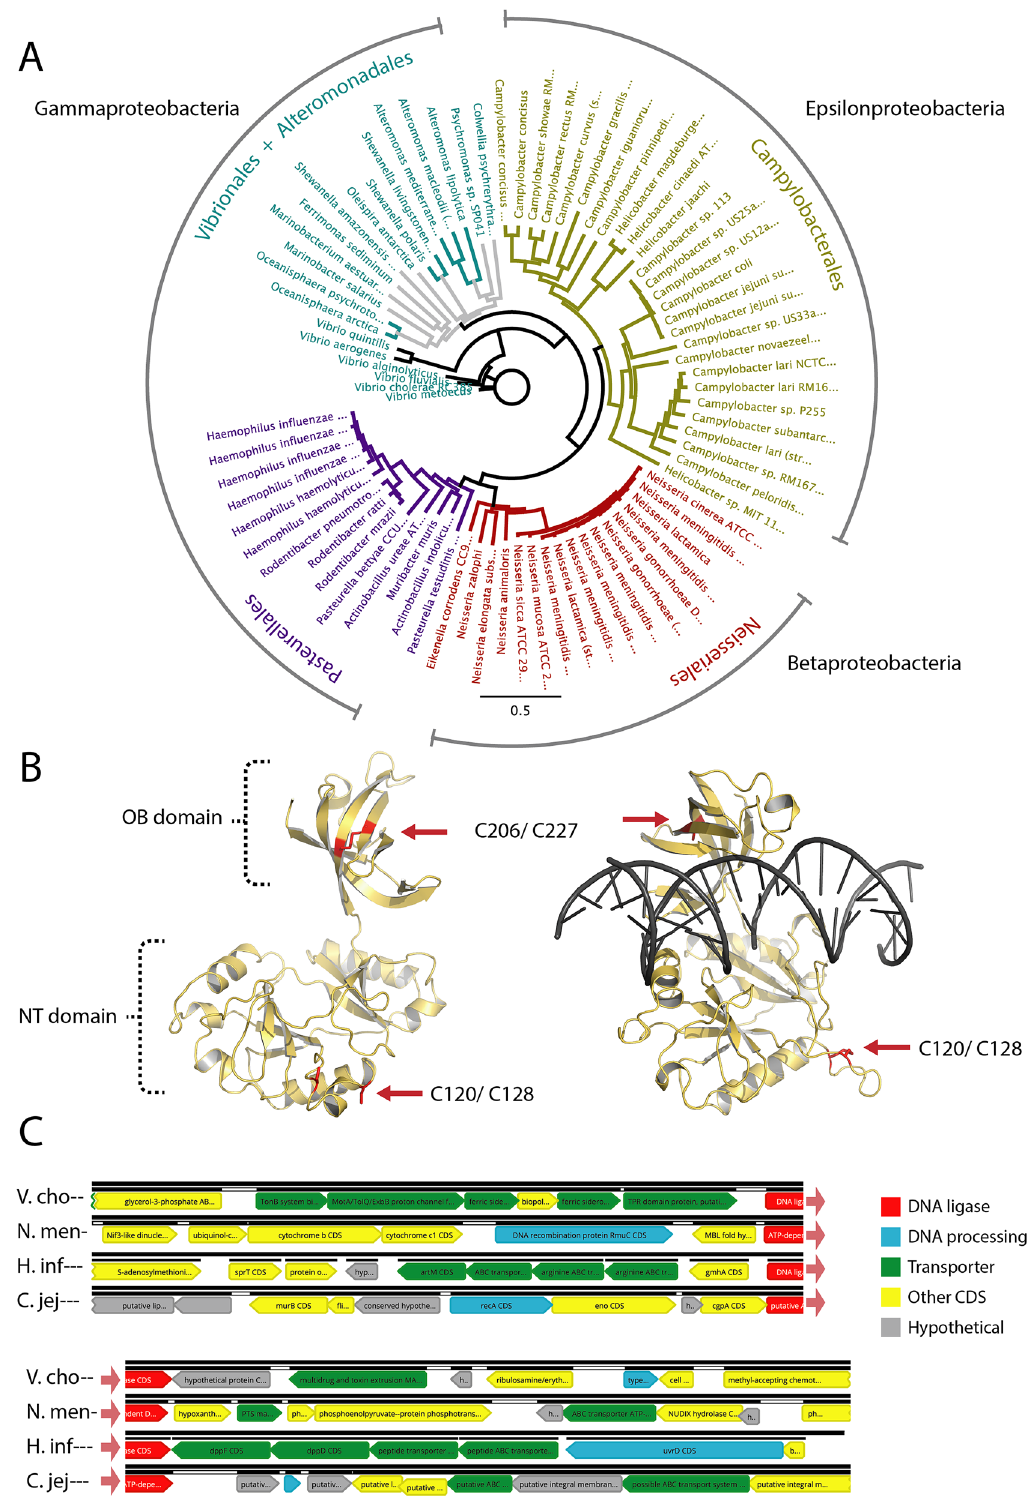
Figure 2. ( A ) Phylogenetic analysis of bacterial Lig E sequences coloured by Order. Solid-coloured branches indicate bootstrap values greater than 50% consensus support. Protein identifiers for ligases are given in Supplementary Table 1. ( B ) Lig E from Campylobacter jejuni modeled in open DNA-free (left) and closed DNA-bound (right) conformations. Potential disulfide bonds in the OB and NT domains are indicated in red. ( C ) Genomic context of Lig E from pathogenic representatives of different bacterial Orders. Species names are abbreviated as: V . cho, Vibrio cholera: N. men , Neisseria meningitidis ; H. infl , Haemophilus influenzae ; C. jej , Campylobacter jejuni . Genes are coloured according to the function annotated in the genomic sequence as DNA processing (blue), transporter (green), other known function unrelated to transport or DNA (yellow) or unknown function (grey). The DNA ligase is coloured red for